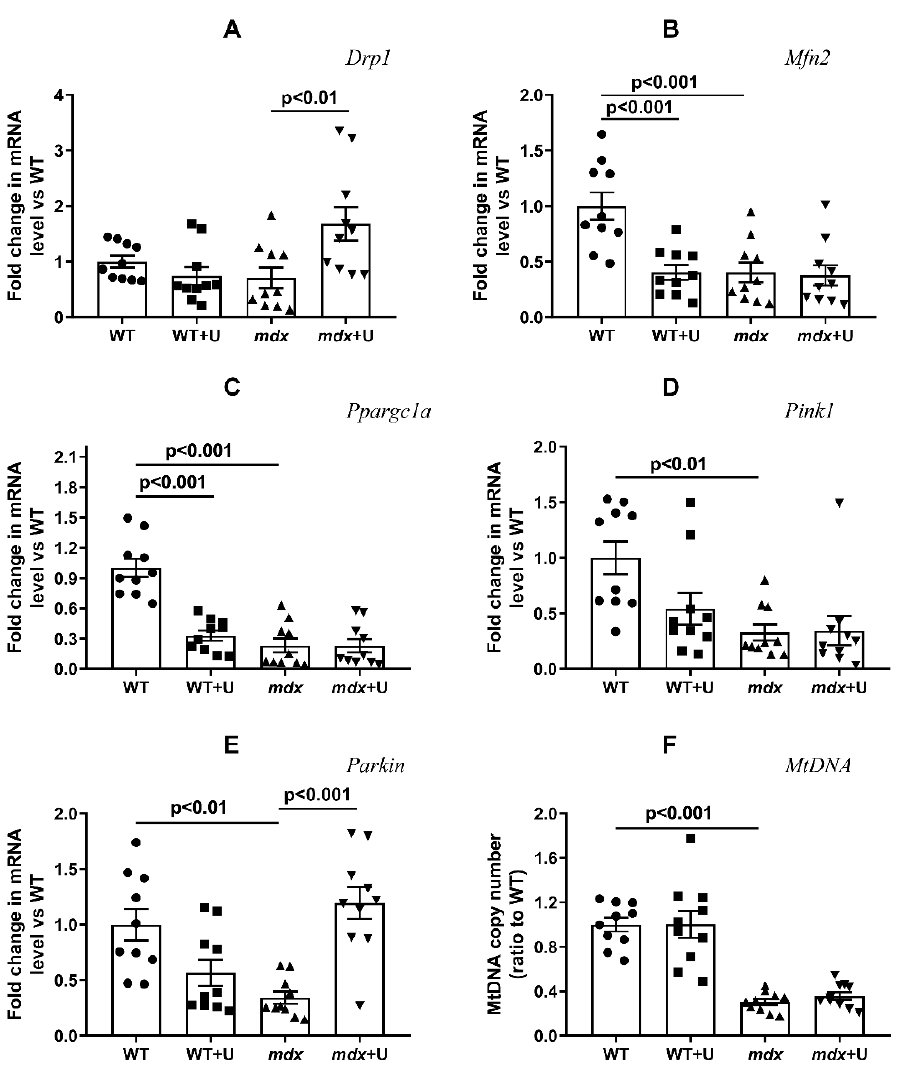
Figure 6. Effect of uridine on mitochondrial dynamics, biogenesis and mitophagy in skeletal muscle. The relative mRNA levels of Drp1 ( A ), Mfn2 ( B ), Ppargc1a ( C ), Pink1 ( D ), Parkin ( E ), and mtDNA ( F ) in the skeletal muscles of experimental animals. The data are presented as means ± SEM ( n = 10).